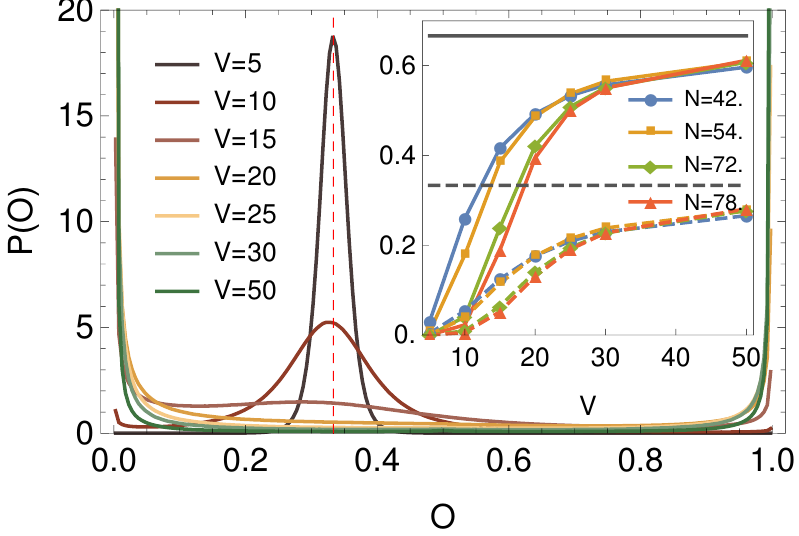
Figure 6: Probability distribution of bond occupation for the system size N = 78. Inset. Integral of P ( O ) over a small interval ( ≤ 5%) near O = 0 (solid lines) and O = 1 (dashed lines), compared to the respective limit values 2 / 3 and 1 /